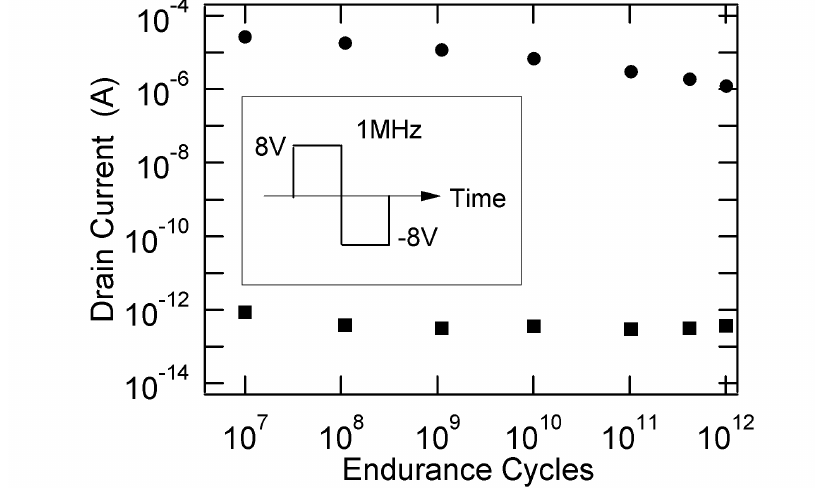
Figure 4. Pulse endurance property of a Pt/SBT/Hf-Al-O/Si FeFET. The inset shows a cycle of the gate voltages which were periodically applied. Reprinted from [15] with permission of